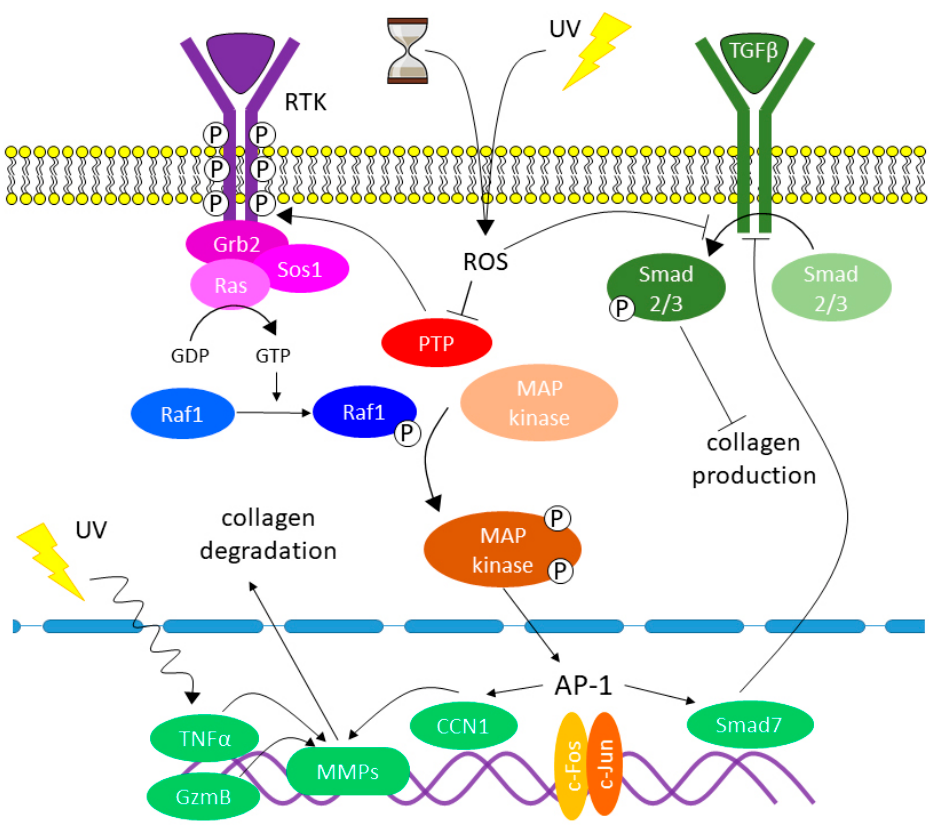
Figure 3. ROS-mediated activation of cascades of molecular signaling pathways in the human skin. AP-1(c-Fos, c-Jun) plays a key role increasing the transcription of genes responsible for the synthesis of MMPs (MMP-1, -3, and -9) [51]. MMP-1 initiates the cleavage of col-